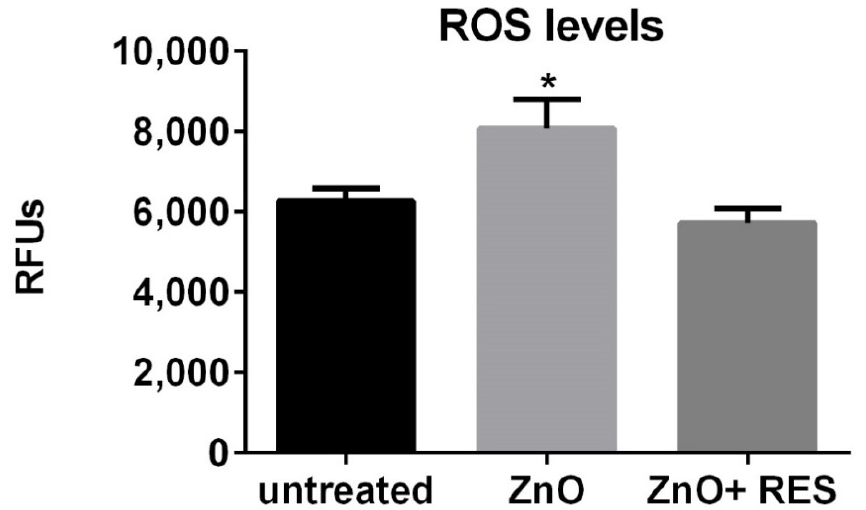
Figure 2. Resveratrol decreases ZnO NP-elicited pro-oxidant effect in zebrafish embryos. Quantitative analysis of ROS level in 72-hpf embryos after exposure to 3 mg/L ZnO NP in the absence (ZnO) or the presence (ZnO + RES) of 5 μM of resveratrol. Fluorescence was measured with a GENios plus microplate reader using a wavelength of 485 nm (excitation) and 535 nm (emission). RES, resveratrol. Values are shown as mean ± SD, n = 5; *, significantly different from untreated.